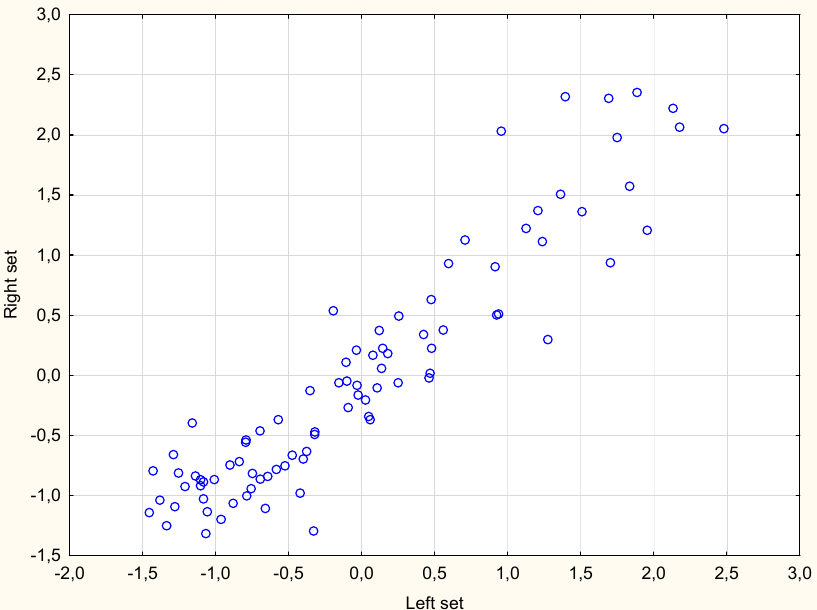
Fig. 3: Scattering diagram of canonical correlations for the first canonical root